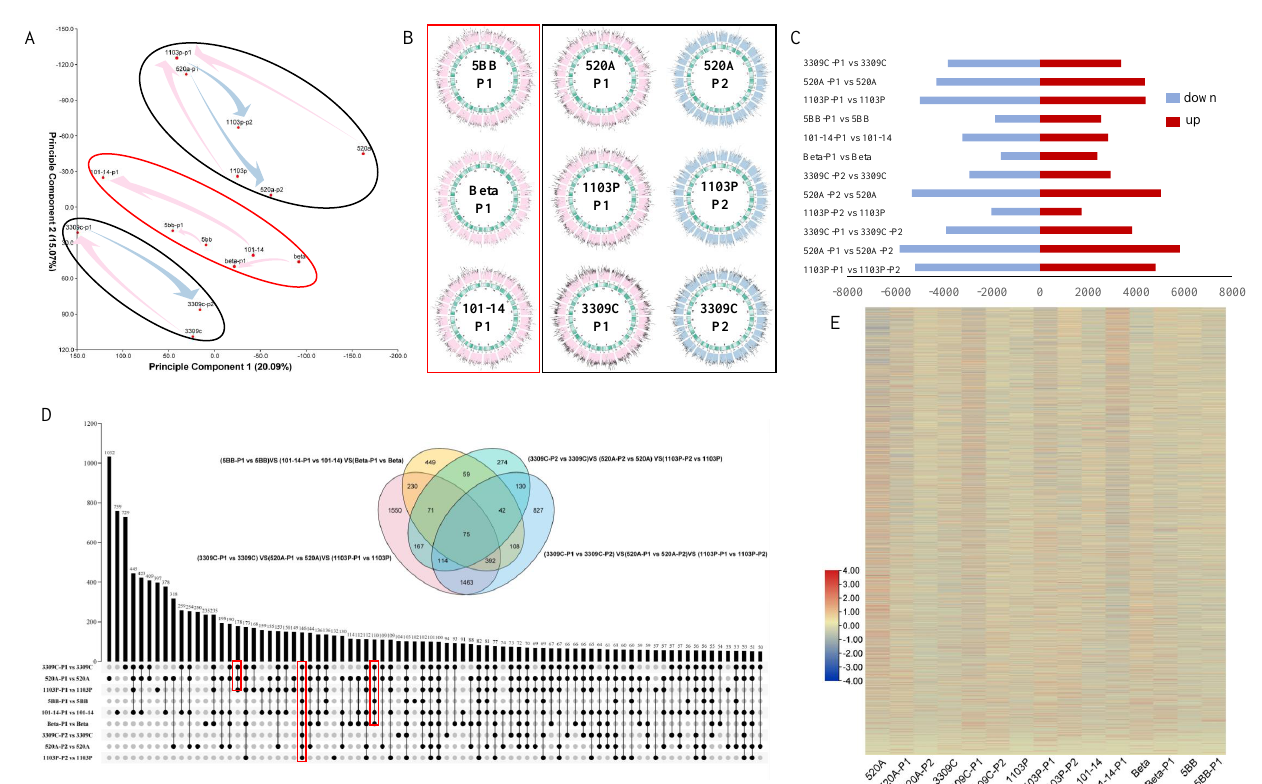
Figure 1. Differentially expressed genes (DEGs) in rootstocks. ( A ) Principal component analysis (PCA): scatterplot of different samples based on the transcriptomic profiles. Pink represents the P1 stage, which is the susceptibility period of intolerant varieties, blue represents the P2 period of the susceptible tolerant varieties, red represents the intolerant varieties, and black represents the tolerant varieties. ( B ) Comparison of the genome expression made by TBtools. In the outer circle, pink represents P1, blue represents P2, and black represents the control group. The heat map in the inner circle represents the distribution of highly expressed genes in the treatment group on the chromosomes. ( C ) Number of up − and downregulated DEGs in samples treated with salt from six rootstocks at two different stages (as shown in Figure 1A). ( D ). DEGs in samples treated with salt from six rootstocks at two different stages (as shown in Figure 1A). The Upset diagram was used to more closely represent the intersection between different temperatures and samples. The green bar graph represents the size of each combination, while a black dot represents yes, a gray dot represents none, and the black bar graph presents the number of intersections. The four − element Venn diagram was used to represent the number of genes with no difference in expression between different groups. Yellow represents DEGs during P1 in intolerant varieties, pink represents DEGs during P1 in tolerant varieties, green represents DEGs during P2 in tolerant varieties, and blue represents differences between P1 and P2 in tolerant varieties. ( E ). Comparison of the transcription level of DEGs using heatmap